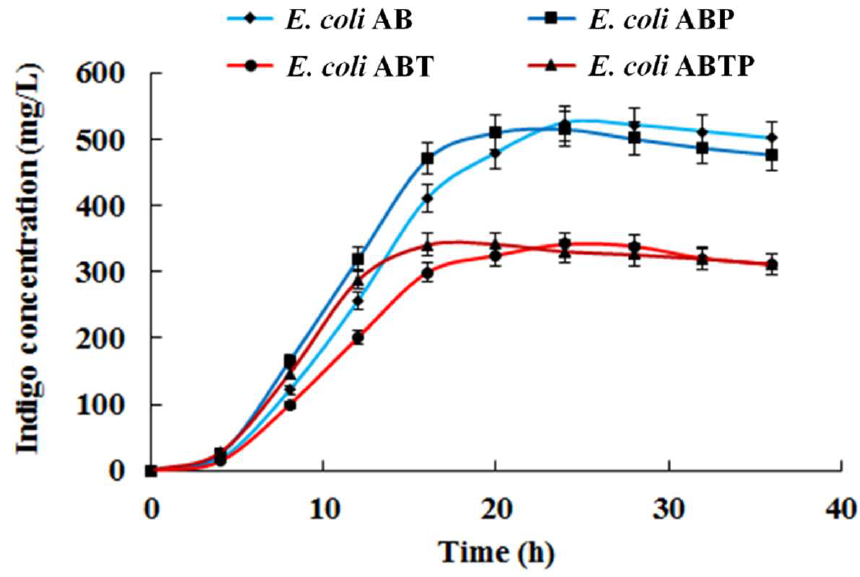
Figure 8. Indigo production from 1.2 mg/mL of tryptophan in fermentation of E. coli AB, E. coli ABP, E. coli ABT, and E. coli ABTP.